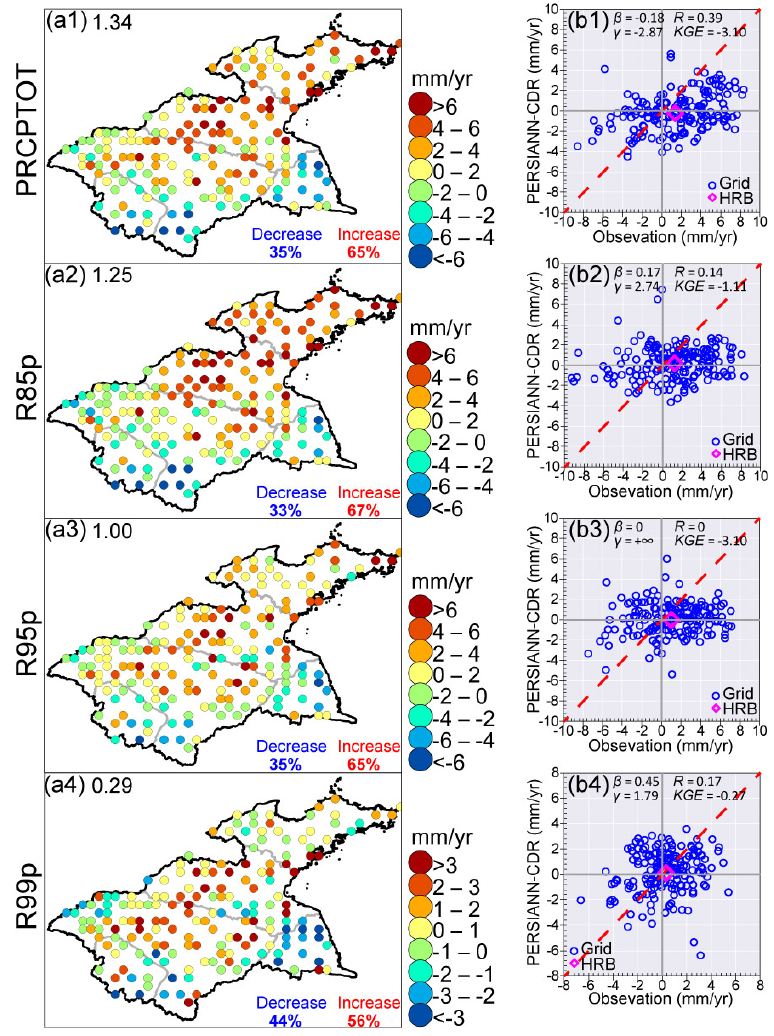
Figure 4. Spatial patterns of the temporal trends of the observational amount-based indices ( a1 – a4 ), and the scatterplots between observation and PERSIANN-CDR. a1 – a4 ( b1 – b4 ) are for PRCPTOT, R85p, R95p, and R99p, respectively. In a1 – a4 , the black numbers represent the HRB trends of the observational amount-based indices, while the blue (red) numbers indicate grid percentages with increasing (decreasing) trend across the HRB. The red dashed line in b1 – b4 is the 1:1 line.